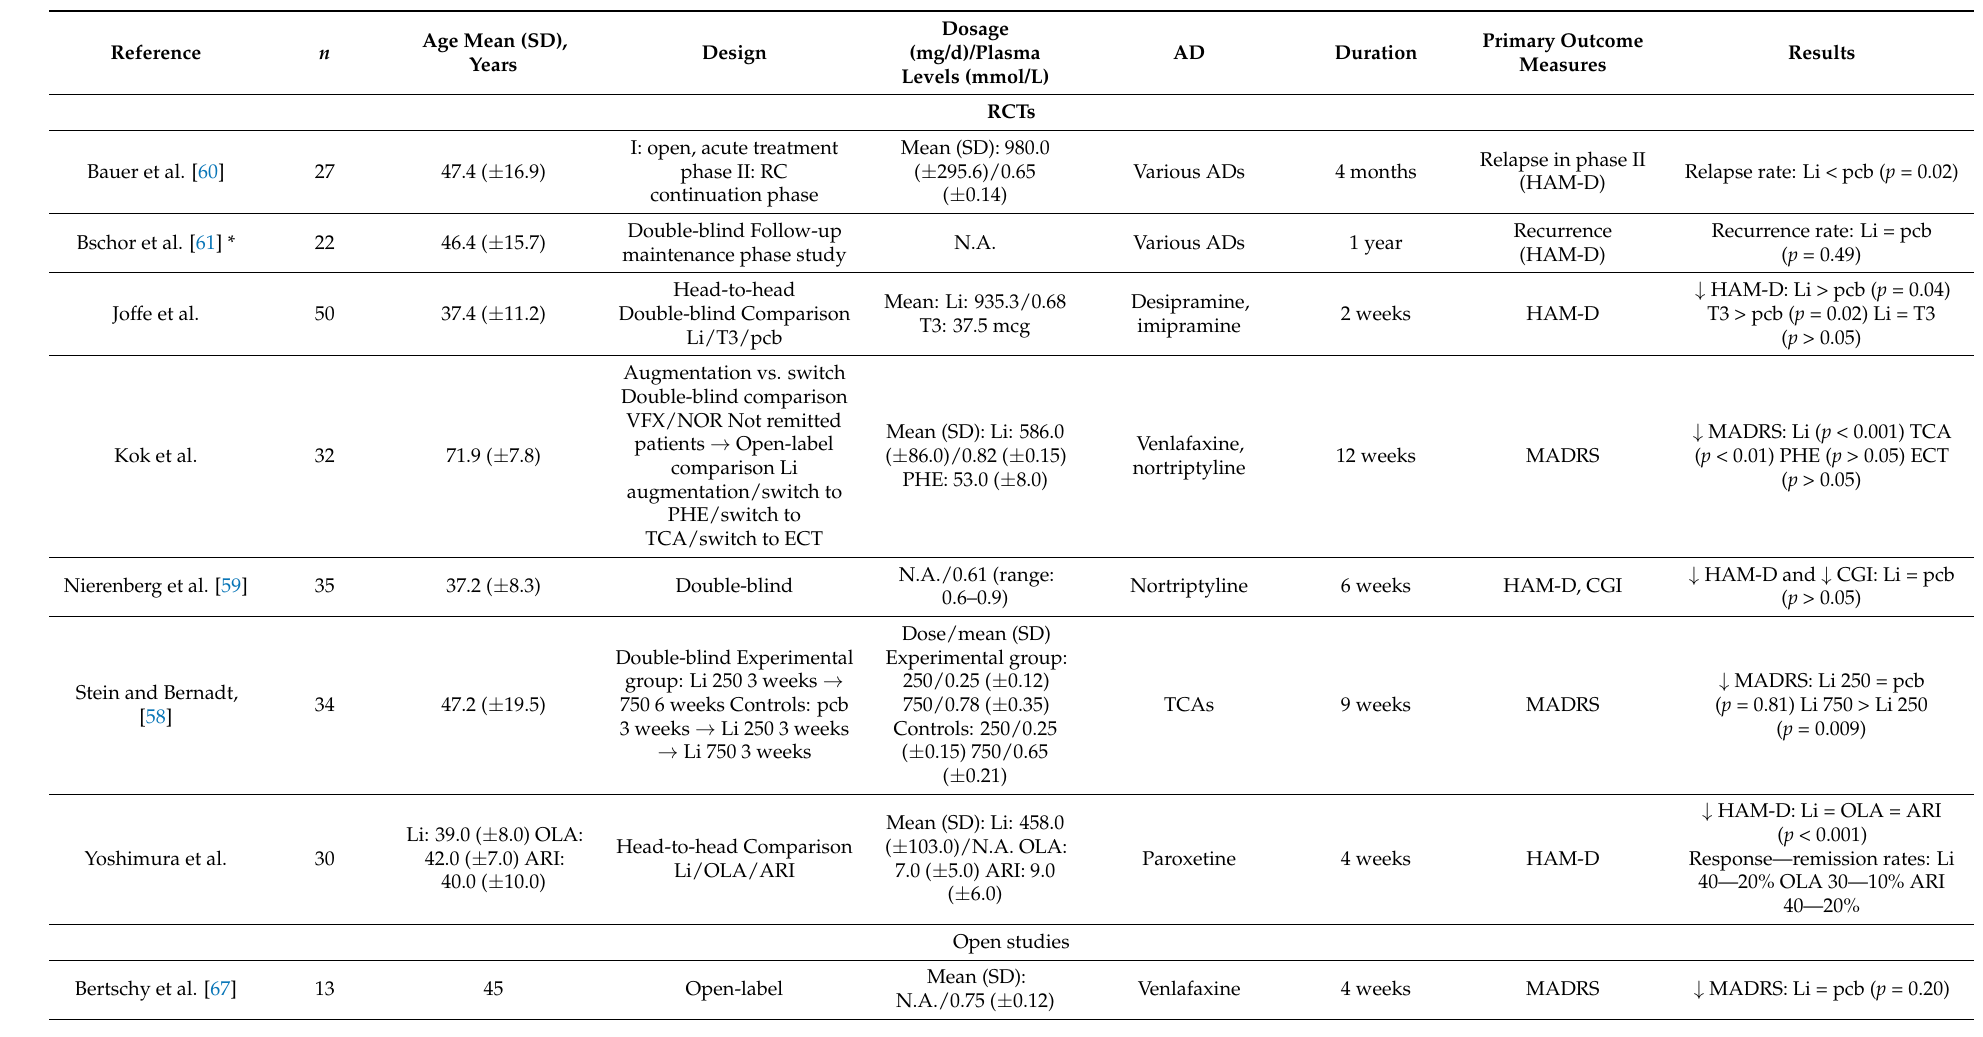
Table 3. Summary of the studies about lithium augmentation in